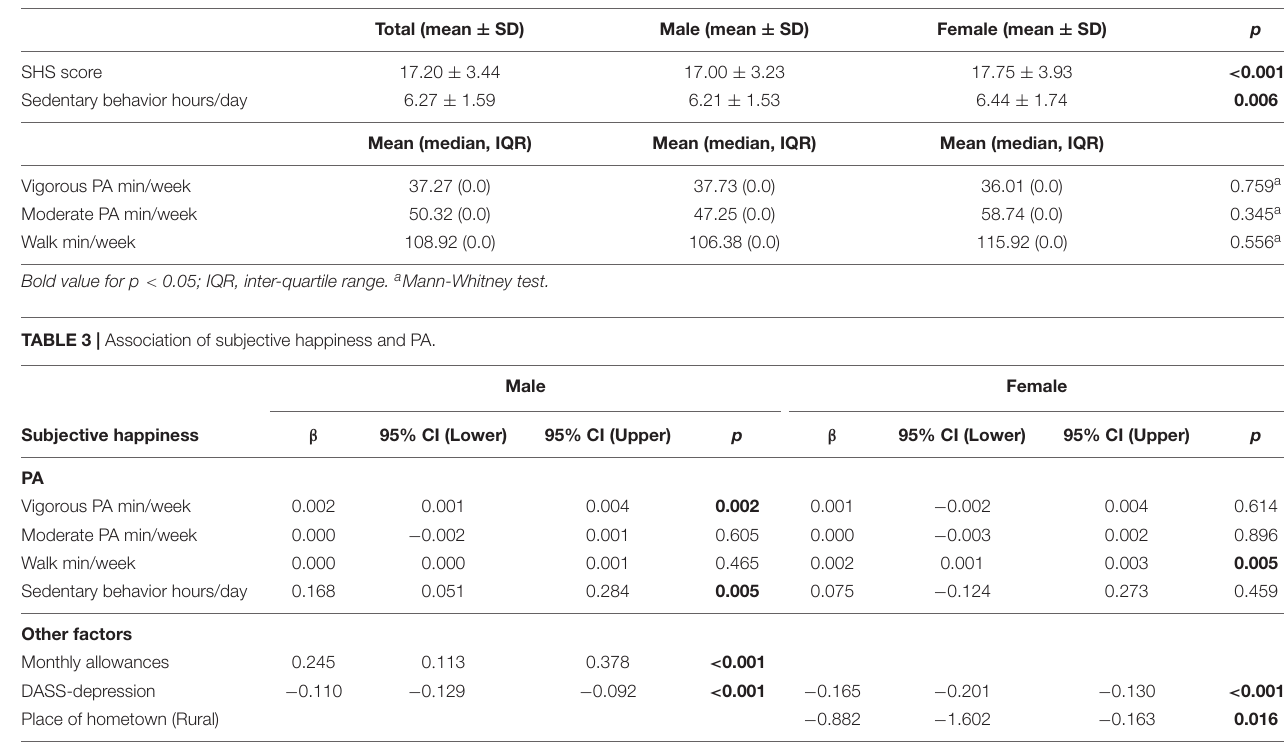
TABLE 2 | Subjective happiness and physical activity of participants by gender.